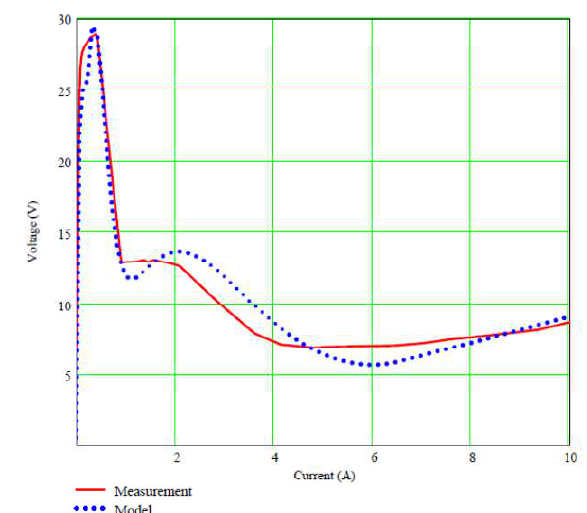
Figure 19: Corresponding V/I characteristic measurement compared to serial “switch model” proposed